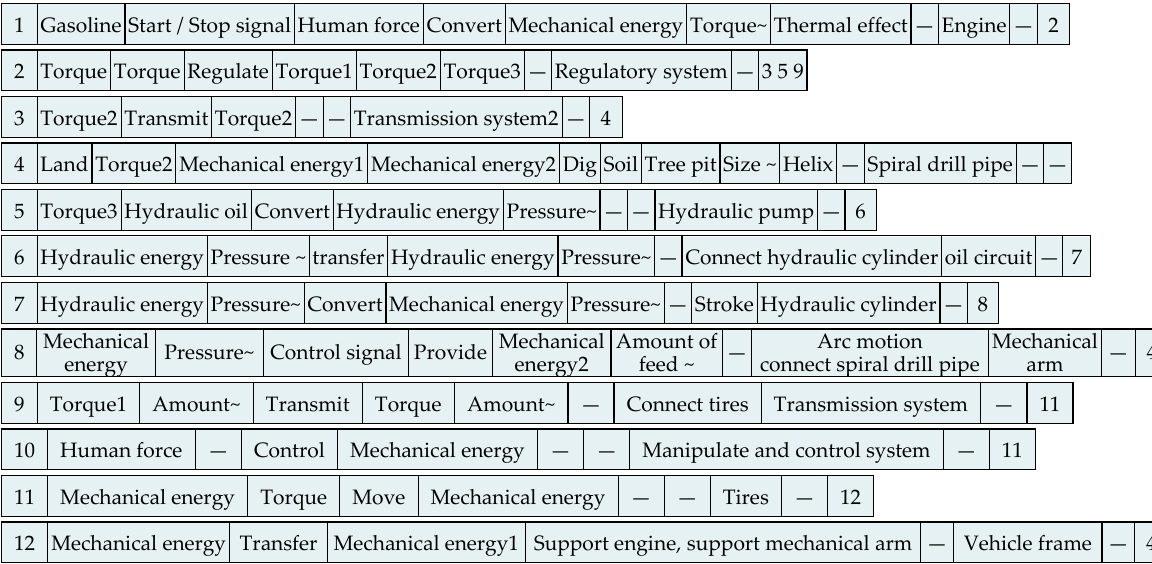
Figure 24. Functional model of the drill pole tree-planting machine.